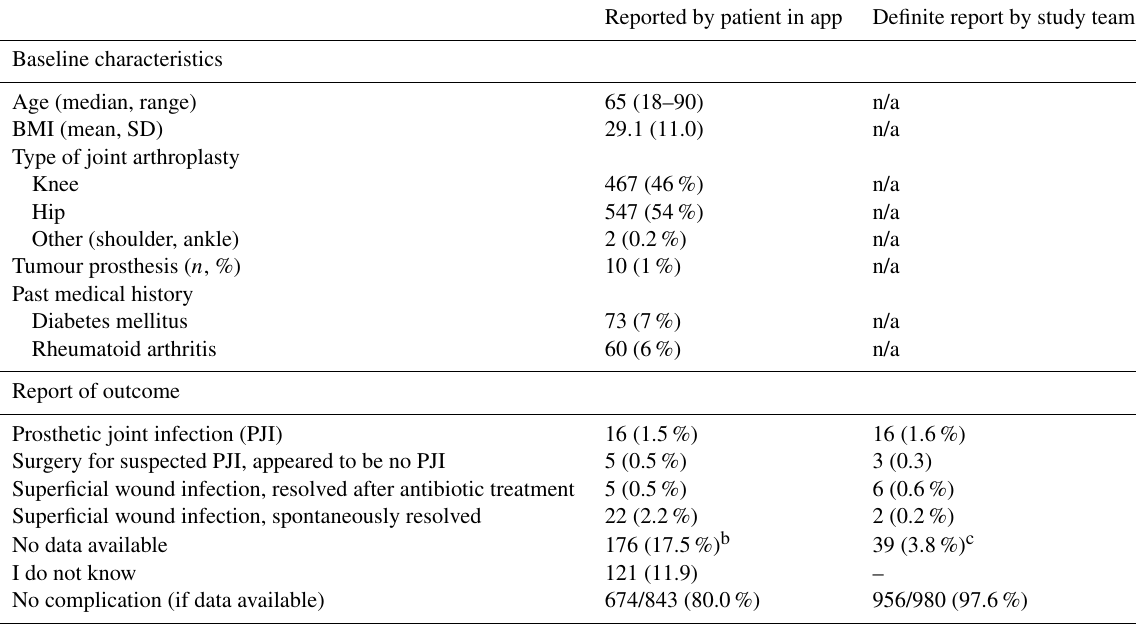
Table 2. Baseline and outcome characteristics of 1019 patients as entered into the app a . Reported by patient in app Definite report by study